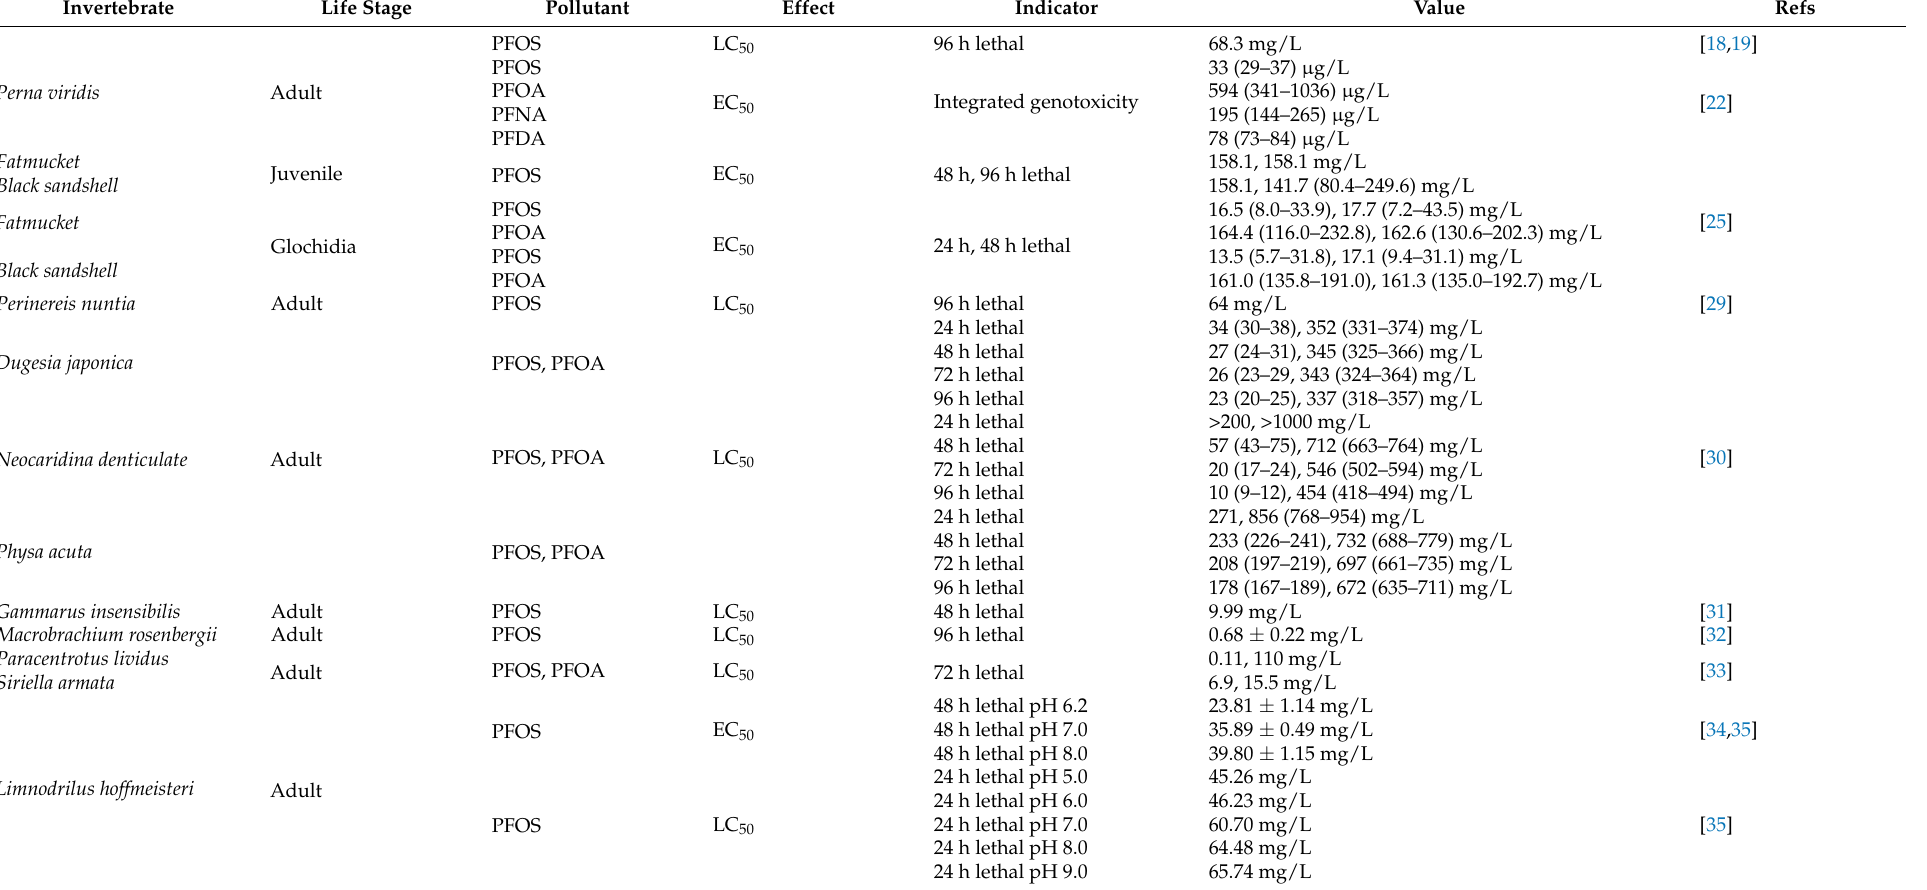
Table 1. EC 50 /LC 50 values of target PFASs and some substitutes on aquatic